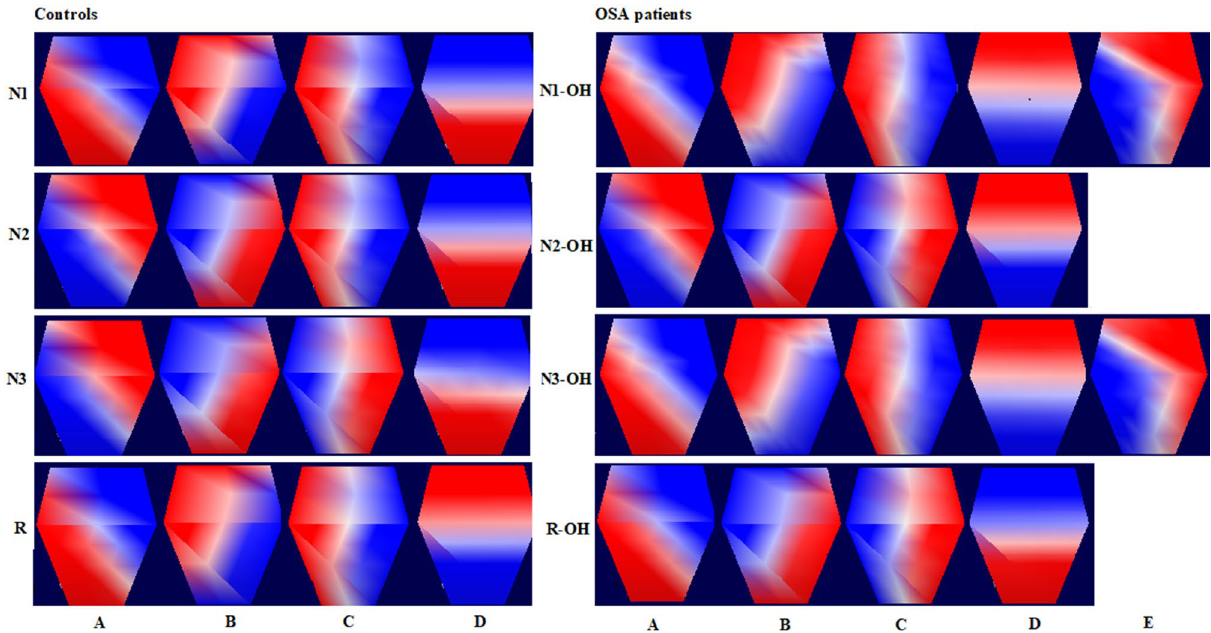
Figure 1. Microstates in W, N1, N2, N3 and R sleep stages in controls and OSA_OH